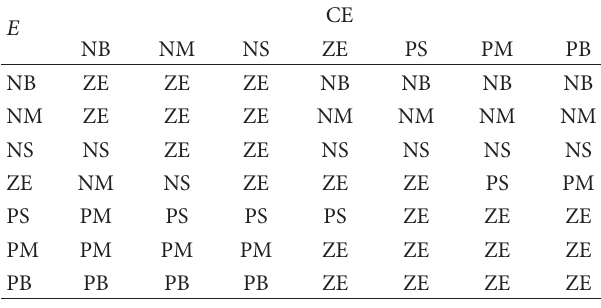
minimum value of the filter capacitance that results in the voltage ripple, 𝐶 min = 𝐷/2𝑓 𝑠 𝑅 ; current ripple factor, CRF = Δ𝐼 𝐿 /𝐼 𝐿 ; voltage ripple factor, VRF = Δ𝑉 𝑜 /𝑉 𝑜